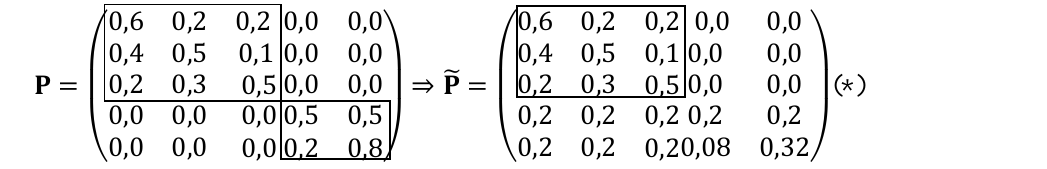
1st: 𝑌 = 10%. 2nd: 𝑌 = 20%. 3rd: 𝑌 = 33% . 4th: 𝑌 = 50% . 5th: 𝑌 = 75%